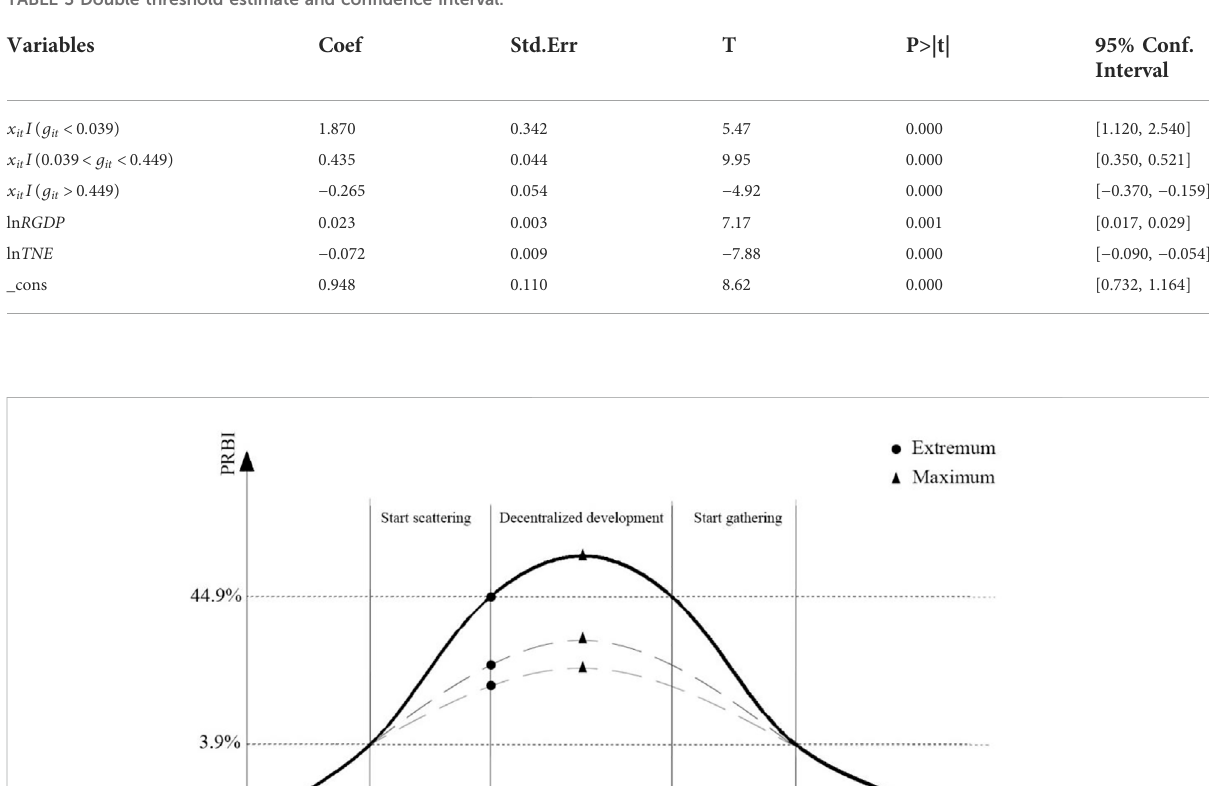
TABLE 3 Double threshold estimate and con fi dence interval.